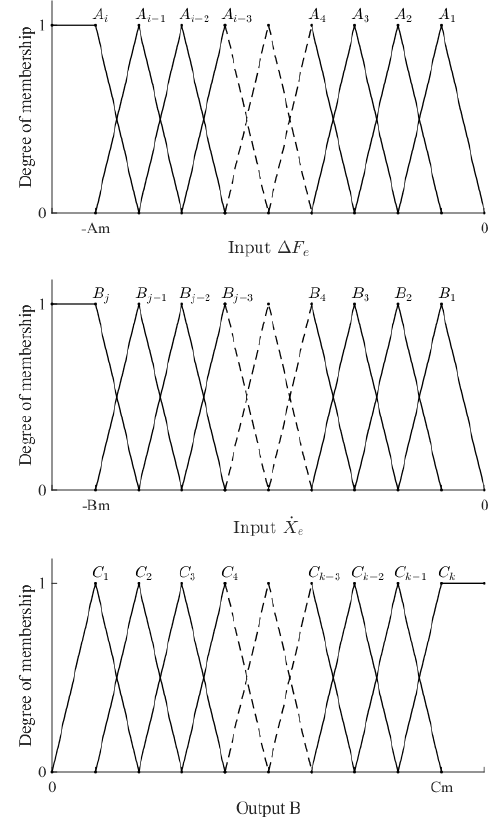
Figure 4. Membership functions of inputs and output.